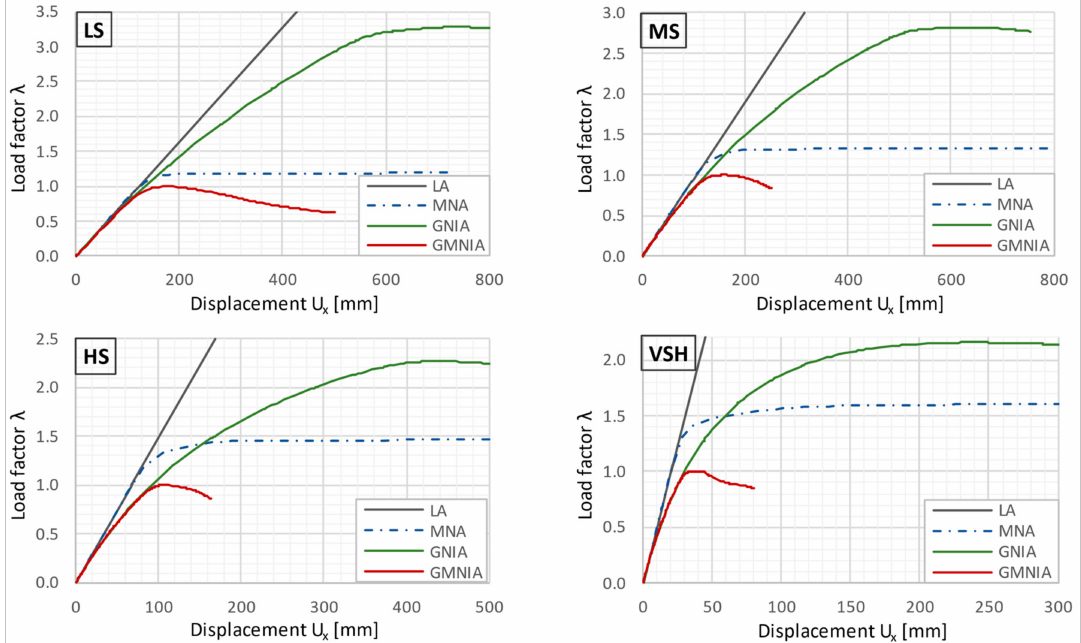
Figure 7. Equilibrium paths of the examined frames as derived with different methods of